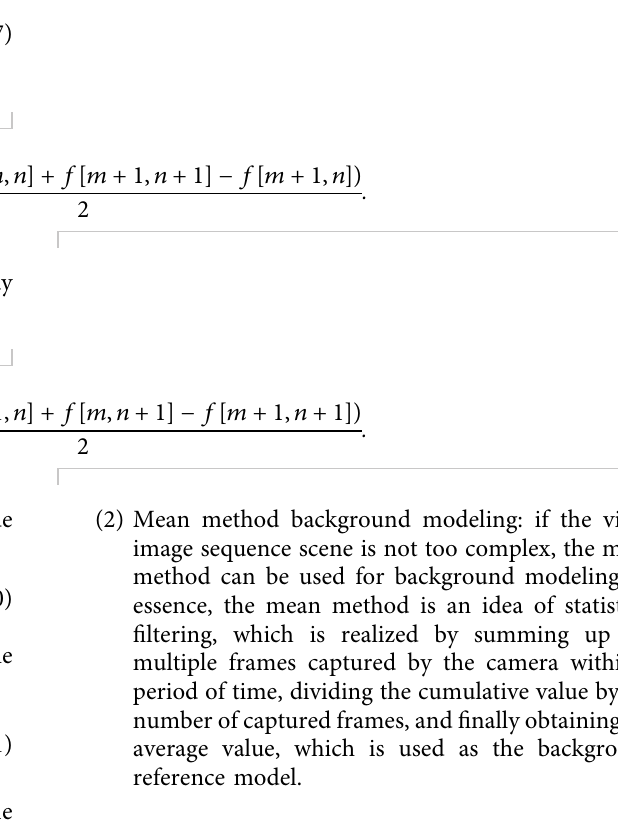
Figure (d) is frame 98 and frame 97 difference diagram. Figure (e) is frame 99 and frame 98 difference diagram. Figure (f) is frame three difference